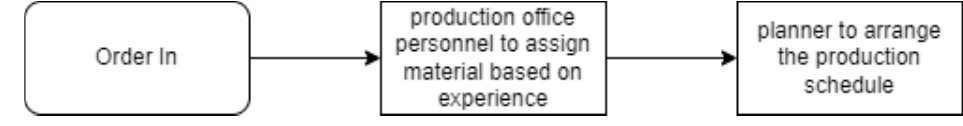
Figure 2. Manual production planning.